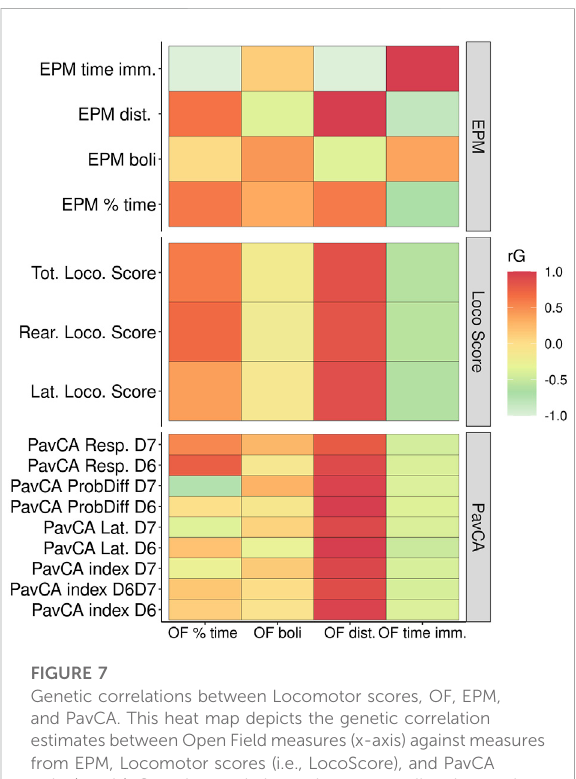
FIGURE 7 Genetic correlations between Locomotor scores, OF, EPM, and PavCA. This heat map depicts the genetic correlation estimates betweenOpen Field measures (x-axis) againstmeasures from EPM, Locomotor scores (i.e., LocoScore), and PavCA traits (y-axis). Genetic correlation estimates as well as the p -values are listed in Supplementary Table